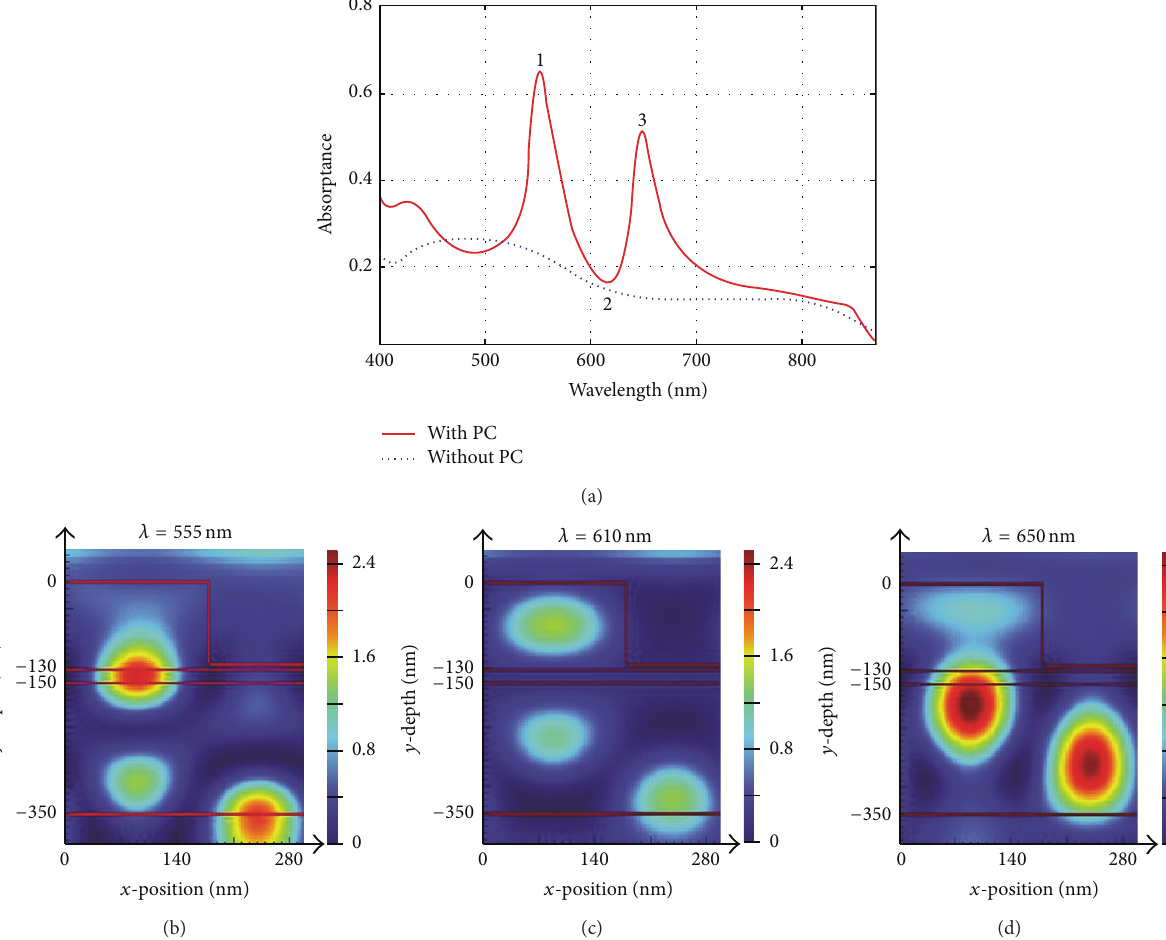
Figure 4: Calculated absorptance spectrum and optical field intensity distribution for a solar cell structure with the following parameters: 20 nm-thick InGaN layer, 130 nm-thick GaN cap layer, 300 nm lattice length, 50% fill factor, and 120nm etch depth. (a) Calculated absorptance. (b) Field distribution at 555 nm wavelength. (c) Field distribution at 610 nm wavelength. (d) Field distribution at 650 nm